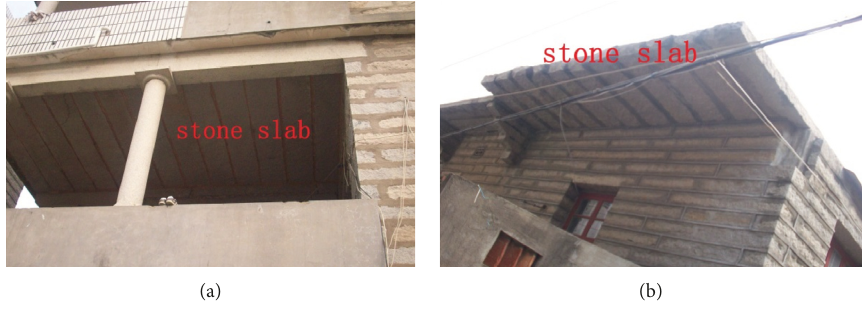
Figure 1: The building floors of stone masonry